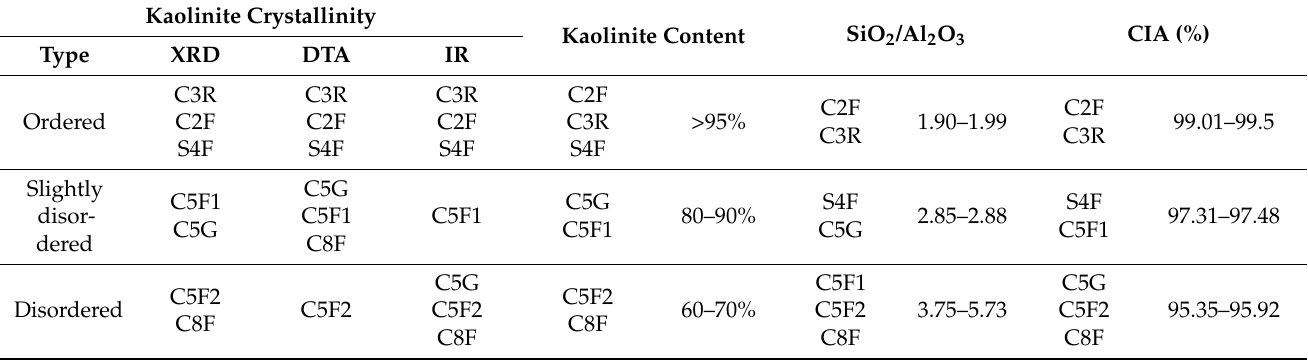
Table 5. Kaolinite crystallinity by petrography, XRD, DTA, IR results and geochemistry index. Kaolinite